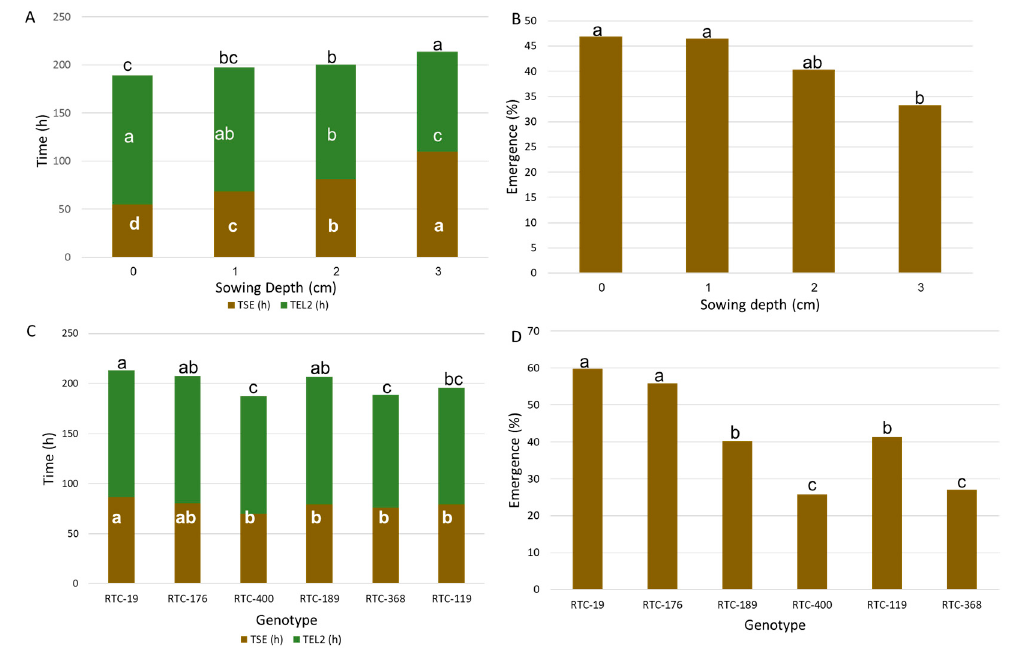
Figure 2. Test-tube experiment. Effects of sowing depth ( A ) and genotype ( C ) on average time from sowing to emergence (TSE, brown segment), time from emergence to second leaf (TEL2, green segment), and time from sowing to second leaf (TSL2, both segments combined). Effects of sowing depth ( B ) and genotype ( D ) on average emergence rate. Different letters indicate significant differences ( p < 0.05).